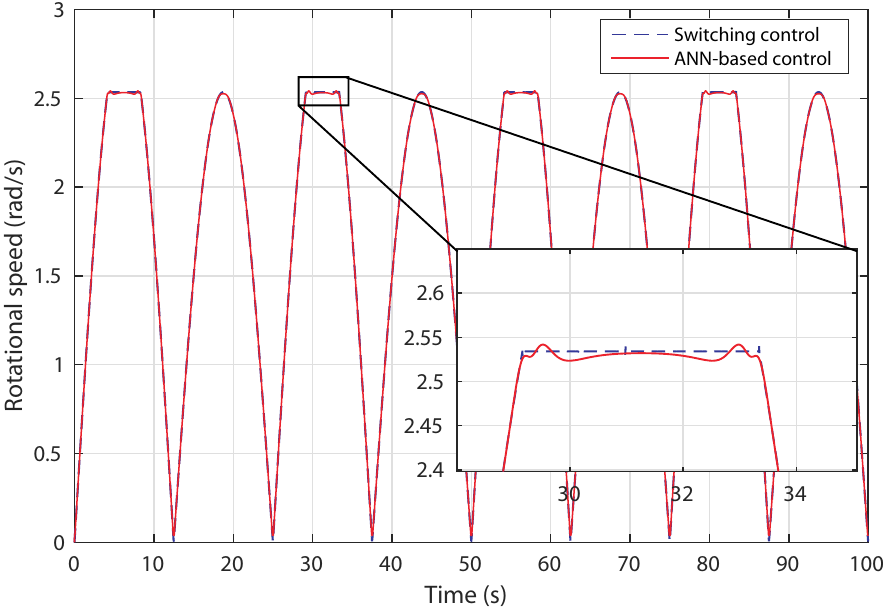
Figure 15. Scenario 1: turbine rotational speed variation.